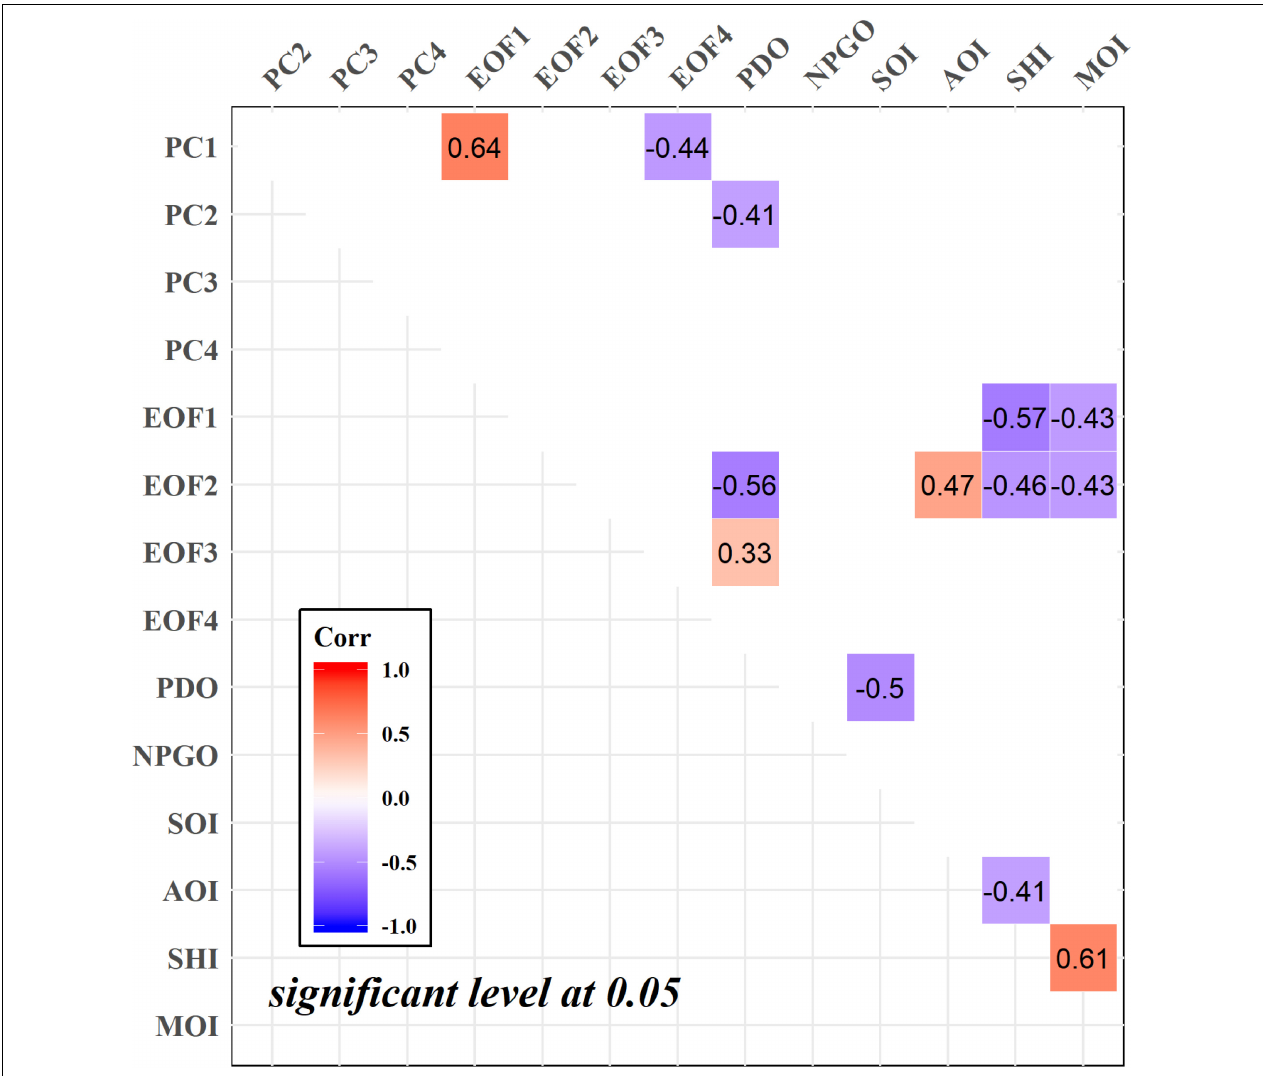
FIGURE 6 | Correlations among principal components (PCs), modes of empirical orthogonal functions (EOFs), and climatic indices (CIs). Colored grids represent significant relationships at a significant level of 0.05 with consideration on the potential autocorrelation. Numbers are correlation coefficients